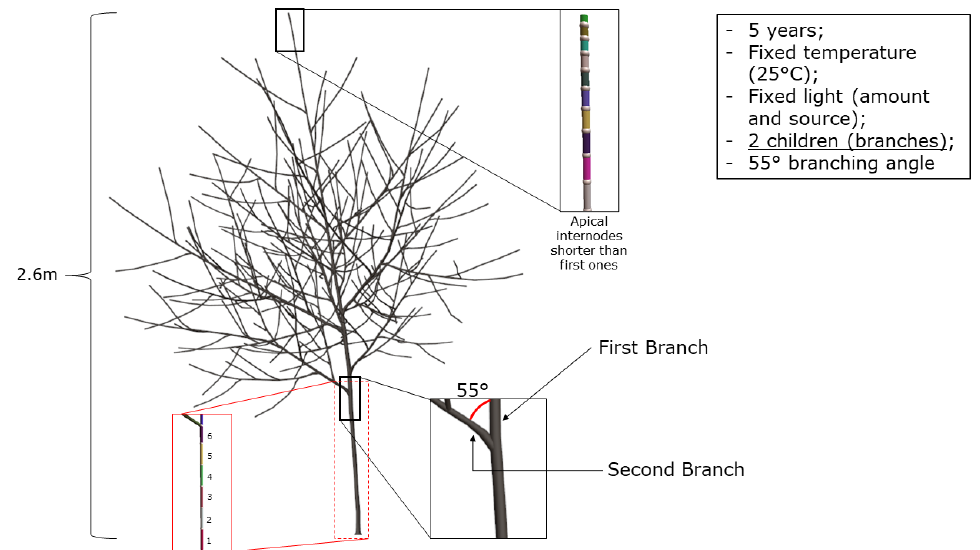
Figure 7. Tree growth with fixed temperature (25 °C), fixed light source (top) and amount, 55° branching angle and 2 children branches. The apical internodes are displayed with different colors for showing purpose.